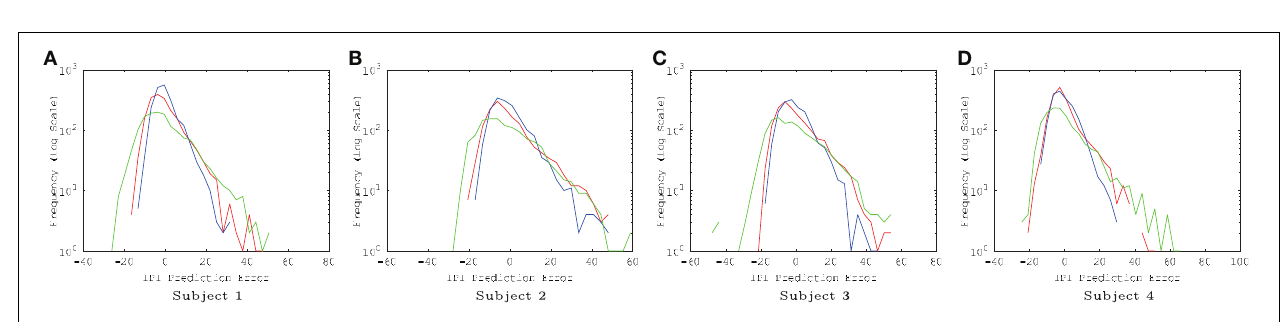
FIGURE 4 | EEG IPI prediction error distribution. The IPI prediction error distribution is shown for all four subjects, each for all three conditions (awake [red], REM [blue], and SWS [green]). The x -axis is in linear scale while the y -axis is in log scale for a clearer view of the probability of extreme error values. The unit for the x -axis was 10ms. The trends are